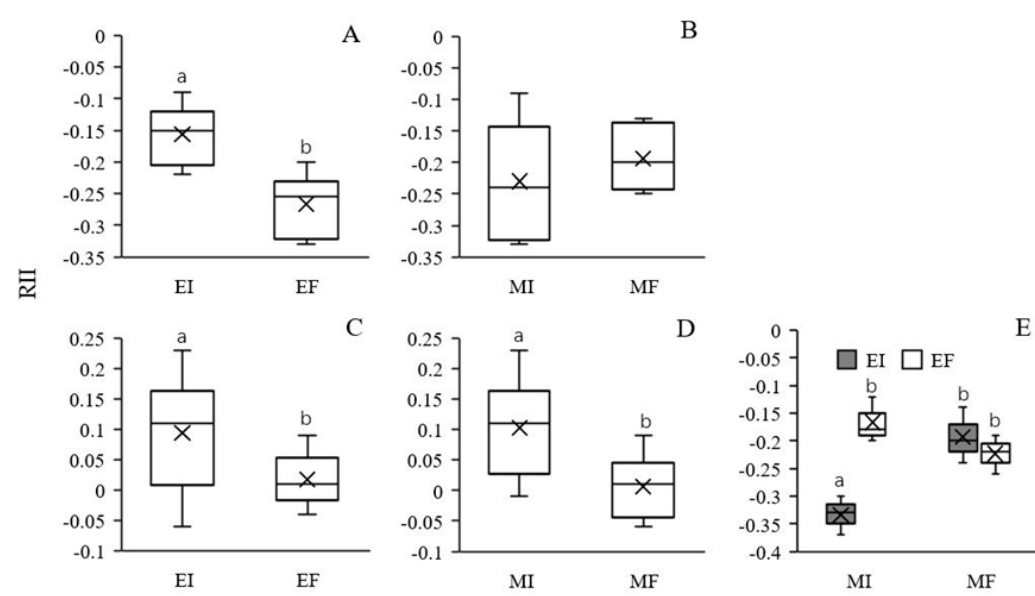
Figure 5. Effects of Epichloë endophyte colonization and soil microbes on the relative interaction intensity index (RII) between EI and EF Leymus chinensis ( A ) and ( B ) in intraspecific competition and between L. chinensis and Stipa krylovii for L. chinensis in interspecific competition ( C ) and ( D ) and effect of the interaction between Epichloë endophyte colonization and soil microbes on the RII between L. chinensis and S. krylovii for S. krylovii in interspecific competition ( E ). The different letters above bars denote means that are significantly different among treatments ( p < 0.05). EI, Epichloë endophyte-colonized L. chinensis ; EF, endophyte-free L. chinensis ; MI, soil microbe inclusive; MF, soil microbe free. Symbol ‘×’, horizontal line in the box, top and bottom of box edges and bars indicate the average value, median, 25% and 75% quartiles, and 5% and 95% quantiles, respectively.